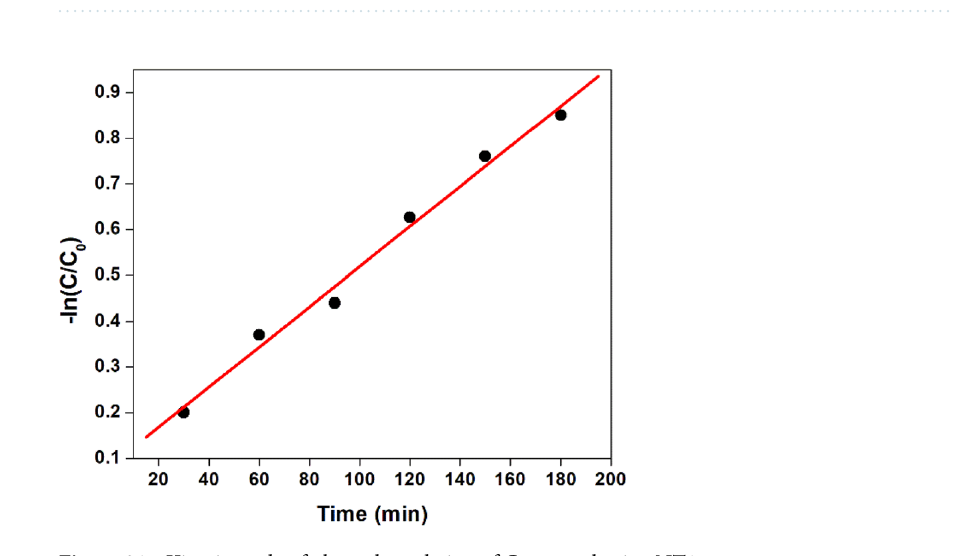
Figure 21. Kinetic study of photo degradation of Congo red using